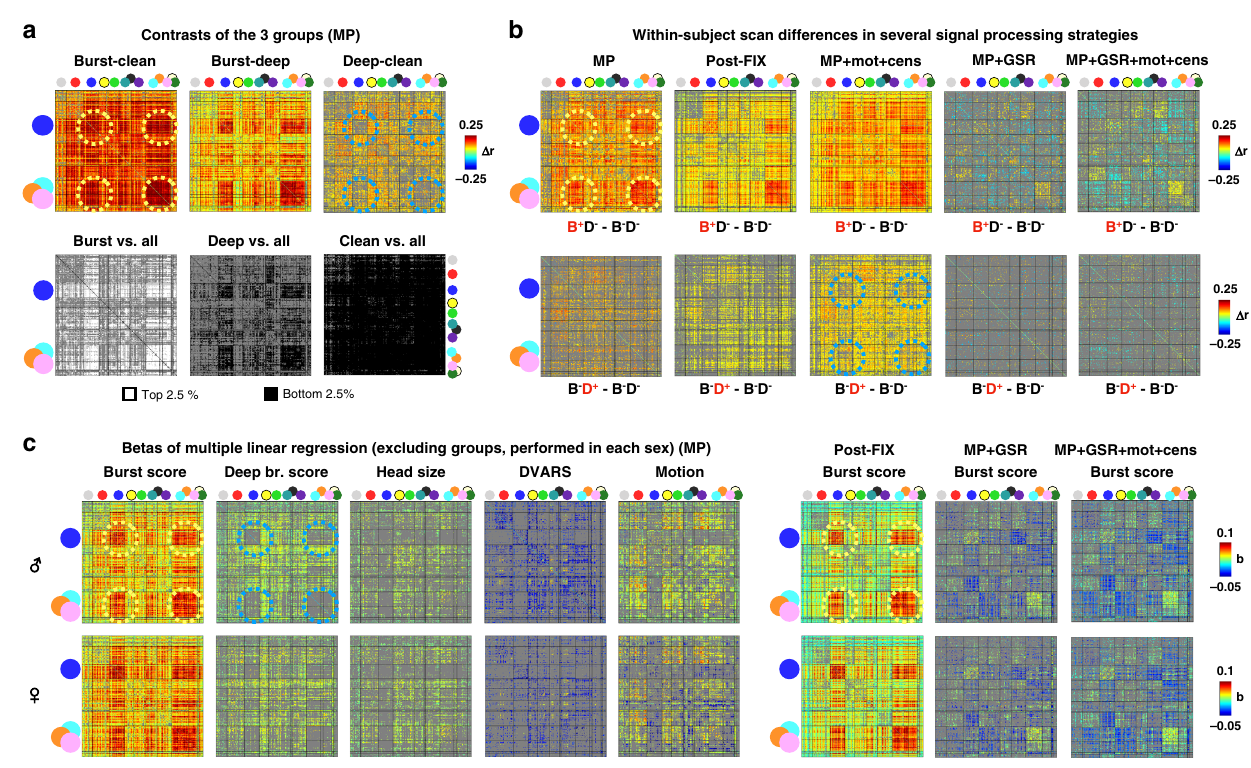
Fig. 6 Functional connectivity associated with breathing patterns. All images color only contrasts or differences signi fi cant at p < 0.05 by 10,000 permutation tests (gray cells are insigni fi cant). a Contrasts of the three groups. The top row shows mean differences between groups. The bottom row shows the rank of mean group correlations amidst random, unrelated groups drawn from the entire cohort. b Mean within-subject differences between scans without breathing patterns (B − D − ) and scans with bursts (B + D − , top row) or deep breaths (B − D + , bottom row) (using only scans where both raters fully agreed). c Betas of multiple linear regression performed separately in each sex, using unrelated, non-group-member subjects only. Regressors were z -scored, and all betas are shown for minimally preprocessed (MP) data. Betas for bursts alone are shown for several other data processing strategies (Supplementary Fig. 11 shows full sets of betas). In each of these three main analyses ( a , b , c ), bursts strongly associated with an increase in sensorimotor correlations (yellow dotted circles), and deep breaths lack elevation in these regions (blue dotted